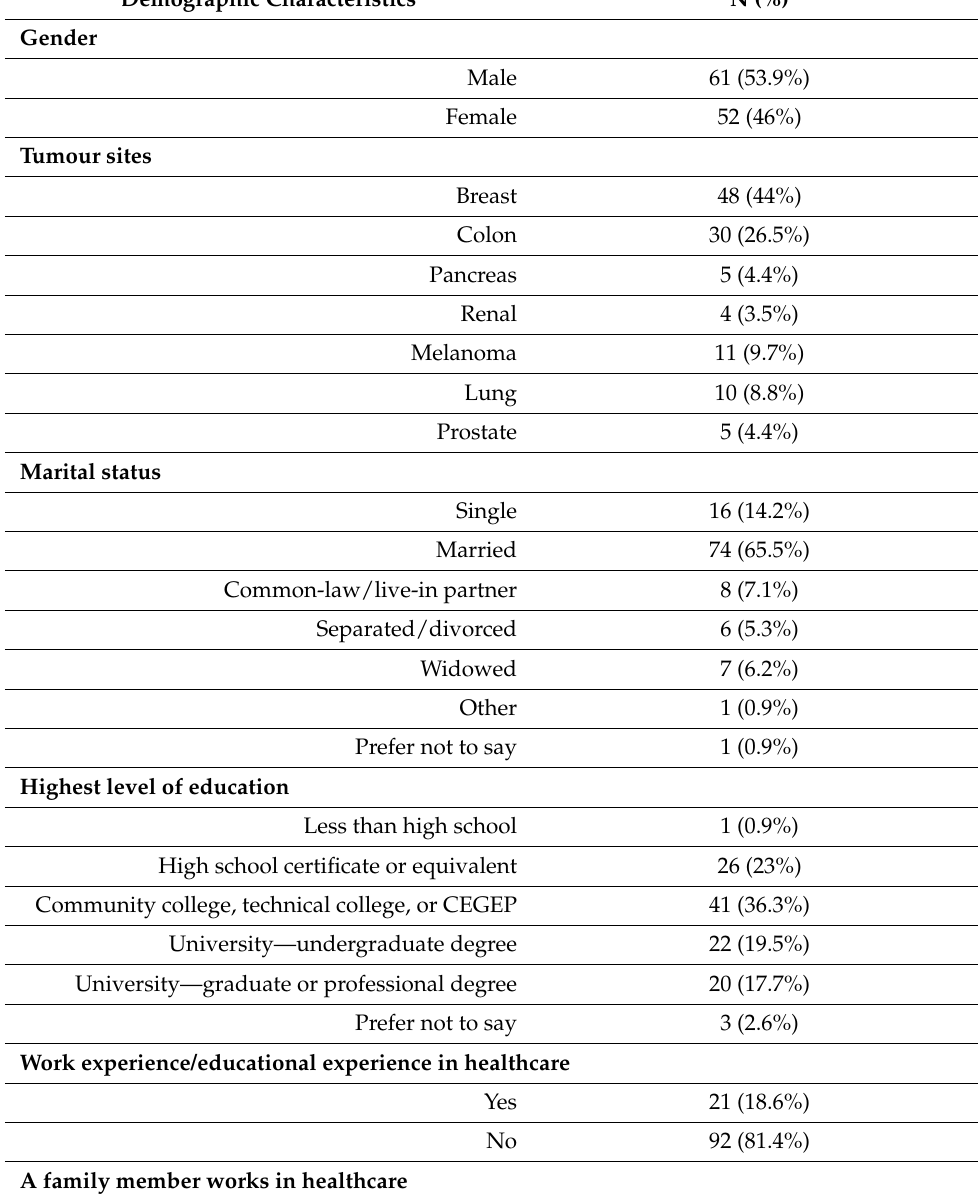
Table 1. Baseline characteristics of